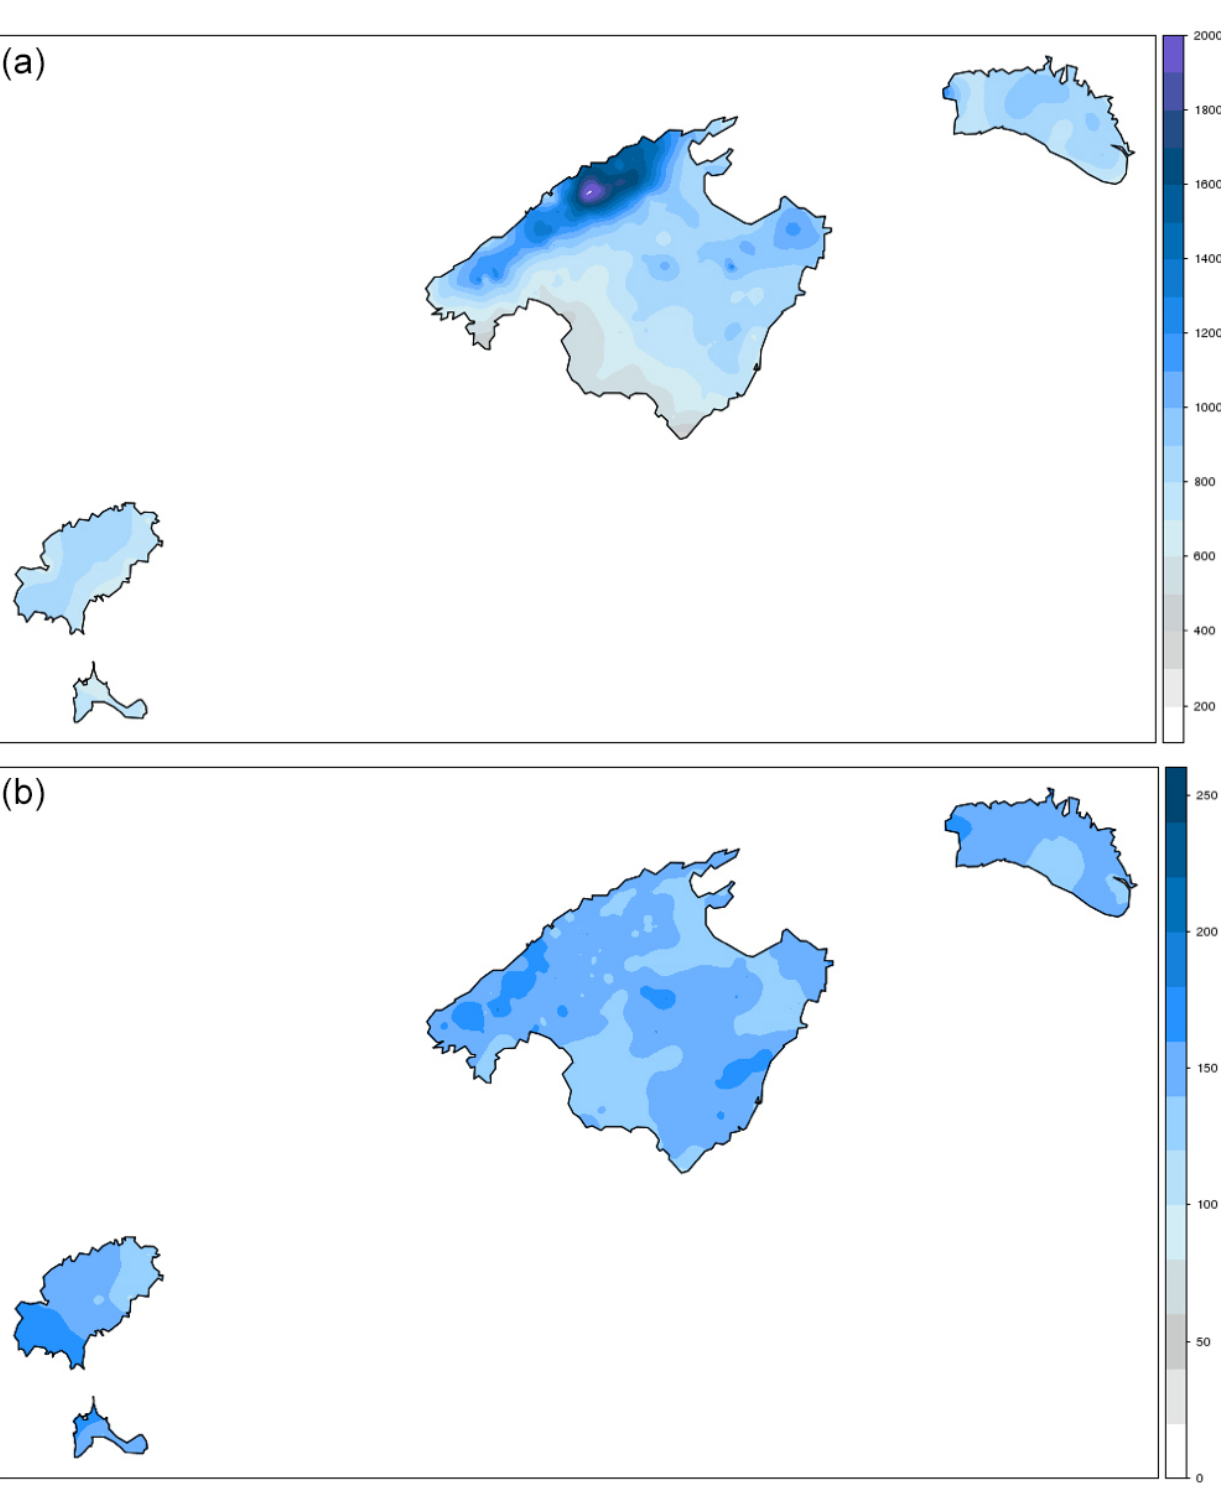
Figure 6. (a) Analyzed annual precipitation (mm) for 1972. (b) Annual precipitation anomaly (mm) for 1972 with respect to the 1950–2009